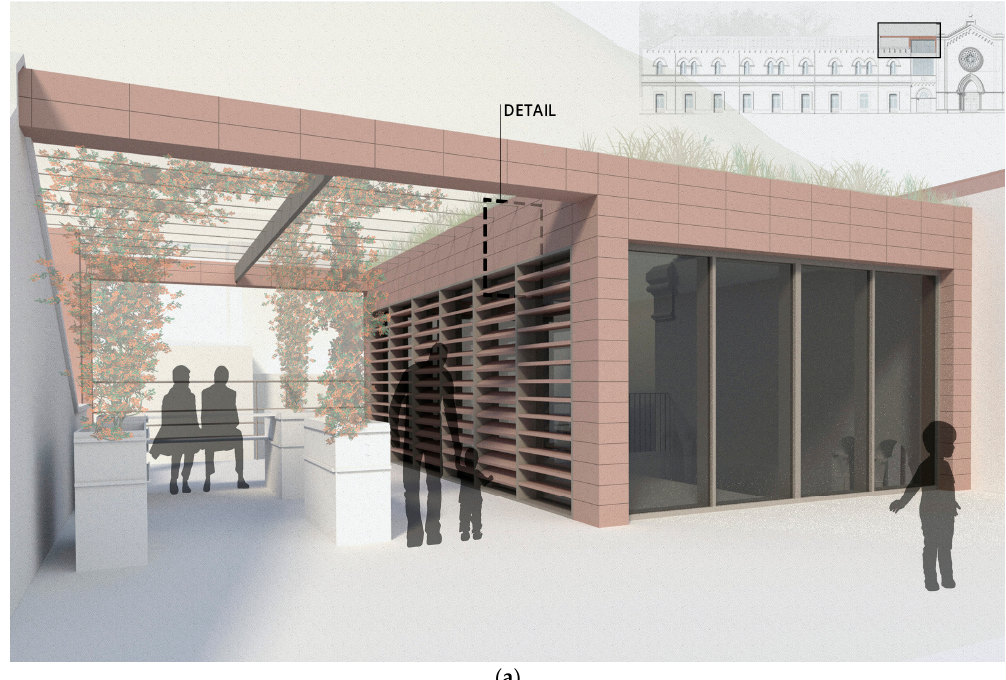
Figure 7. The adaptive reuse project. ( a ) First floor plan. ( b ) Ground floor